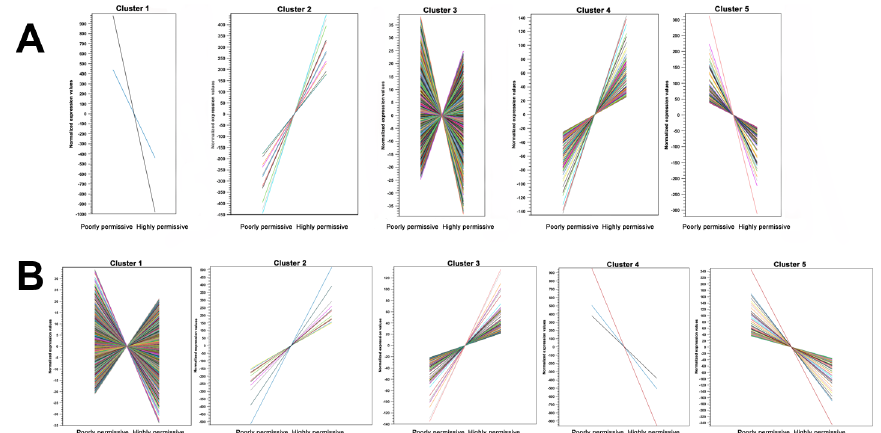
Fig 3. K-means clustering of genes with differential transcription in comparisons of highly permissive against poorly permissive microglia. The five clusters generated in the comparisons of mock-inoculated (A) and scrapie-inoculated (B) microglia clones are depicted. Each color line represents a single gene included in each cluster. The y — axis shows normalized expression values (RPKM), and microglia clones are on the x —